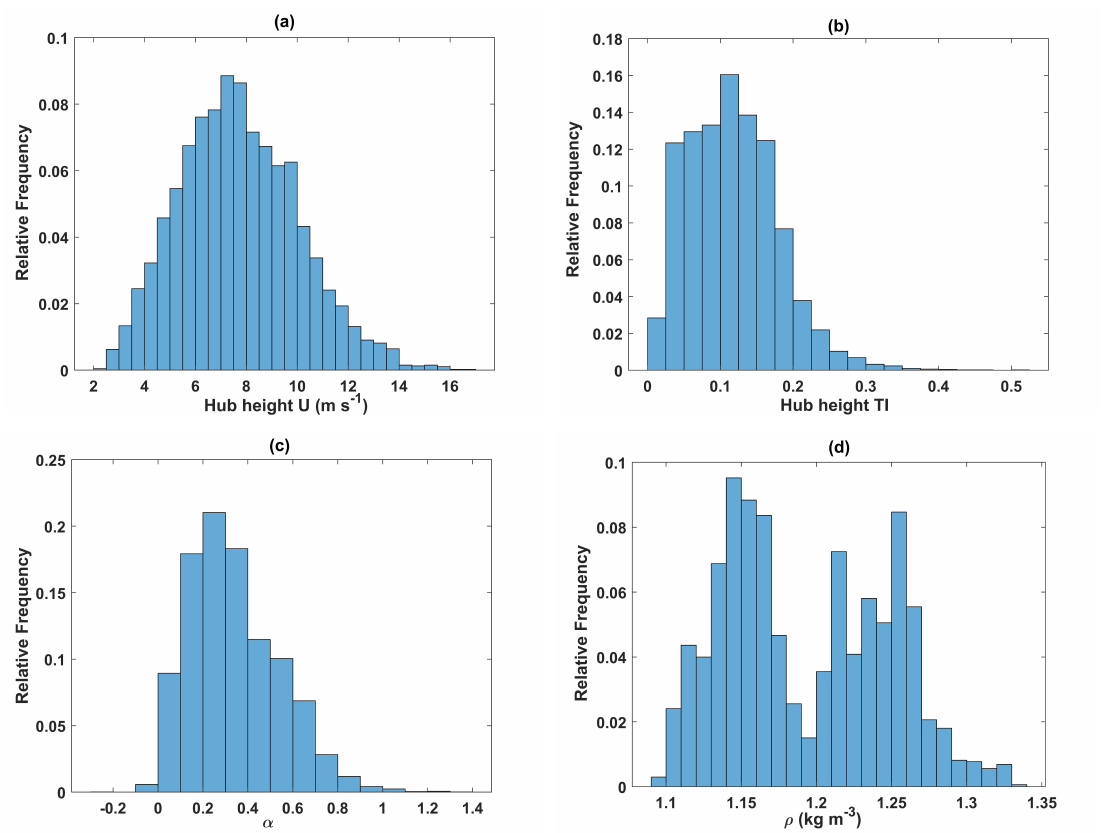
Figure 10. Observed distribution of ten-minute averaged atmospheric variables, including: ( a ) hub-height wind speed (m s − 1 ), ( b ) hub-height turbulence intensity ( TI ), ( c ) shear exponent, ( d ) hub-height air density (kg m − 3